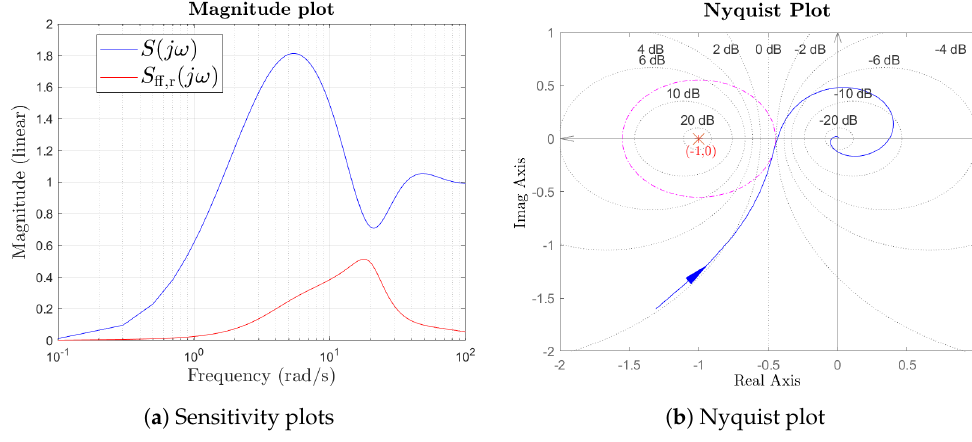
Figure 12. Closed–loop frequency domain results for IMC–s with τ c = 0.27